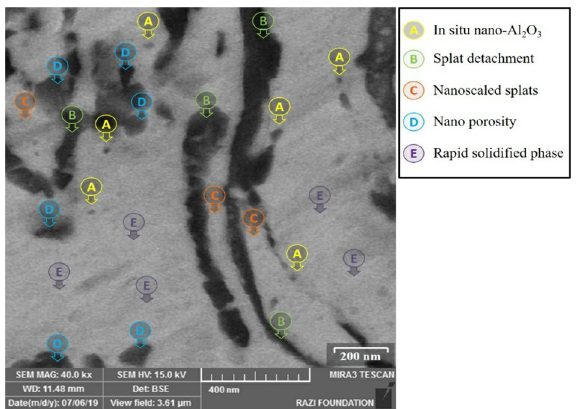
Figure 8. High-resolution FESEM micrograph of the splat formation and detailed structure of the nanocrystalline MCrAlY coating obtained from milled powder after 15 h (backscatter electron